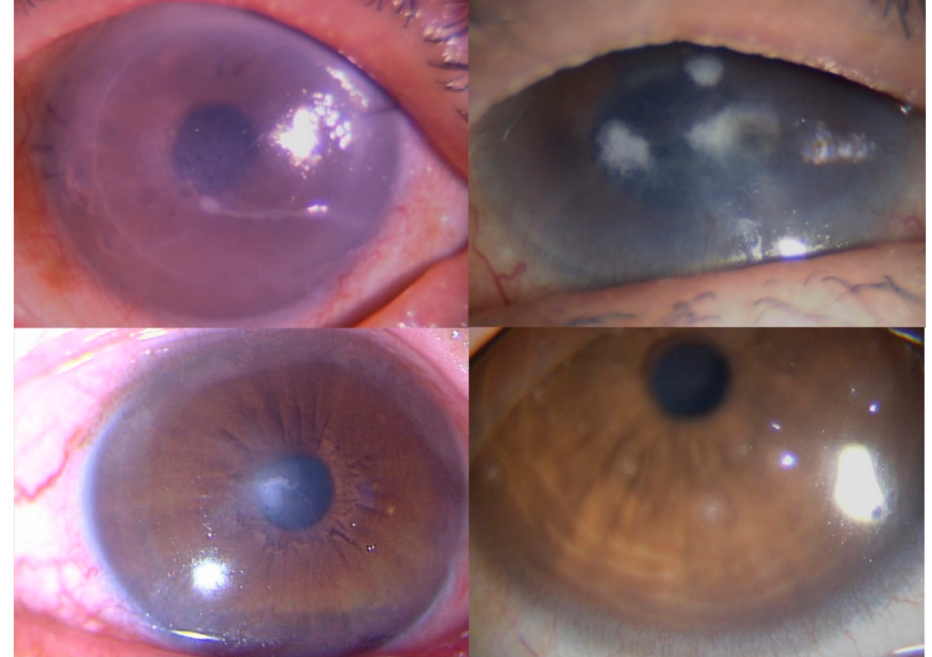
Figure 1. Images demonstrating keratitis in Cases 1, 11, 13, and 16. (Top left) Slit-lamp photograph showing a corneal edema in Case 1. (Top right) Slit-lamp photograph showing a multiple corneal infiltration in Case 11. (Bottom left) Slit-lamp photograph showing an irregular corneal infiltration in Case 13. (Bottom right) Slit-lamp photograph showing a multiple elevated, white-grey, granular, intraepithelial corneal lesions.